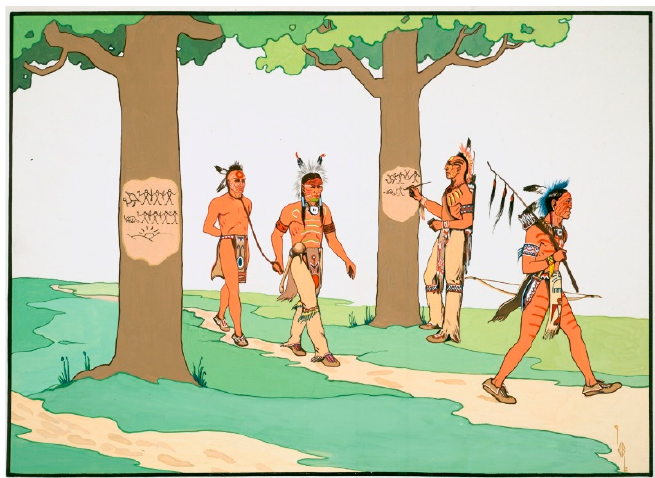
Figure 12. Ernest Smith, The War Party , 1940. Watercolor on board, with permission of the Rochester Museum and Science Center.